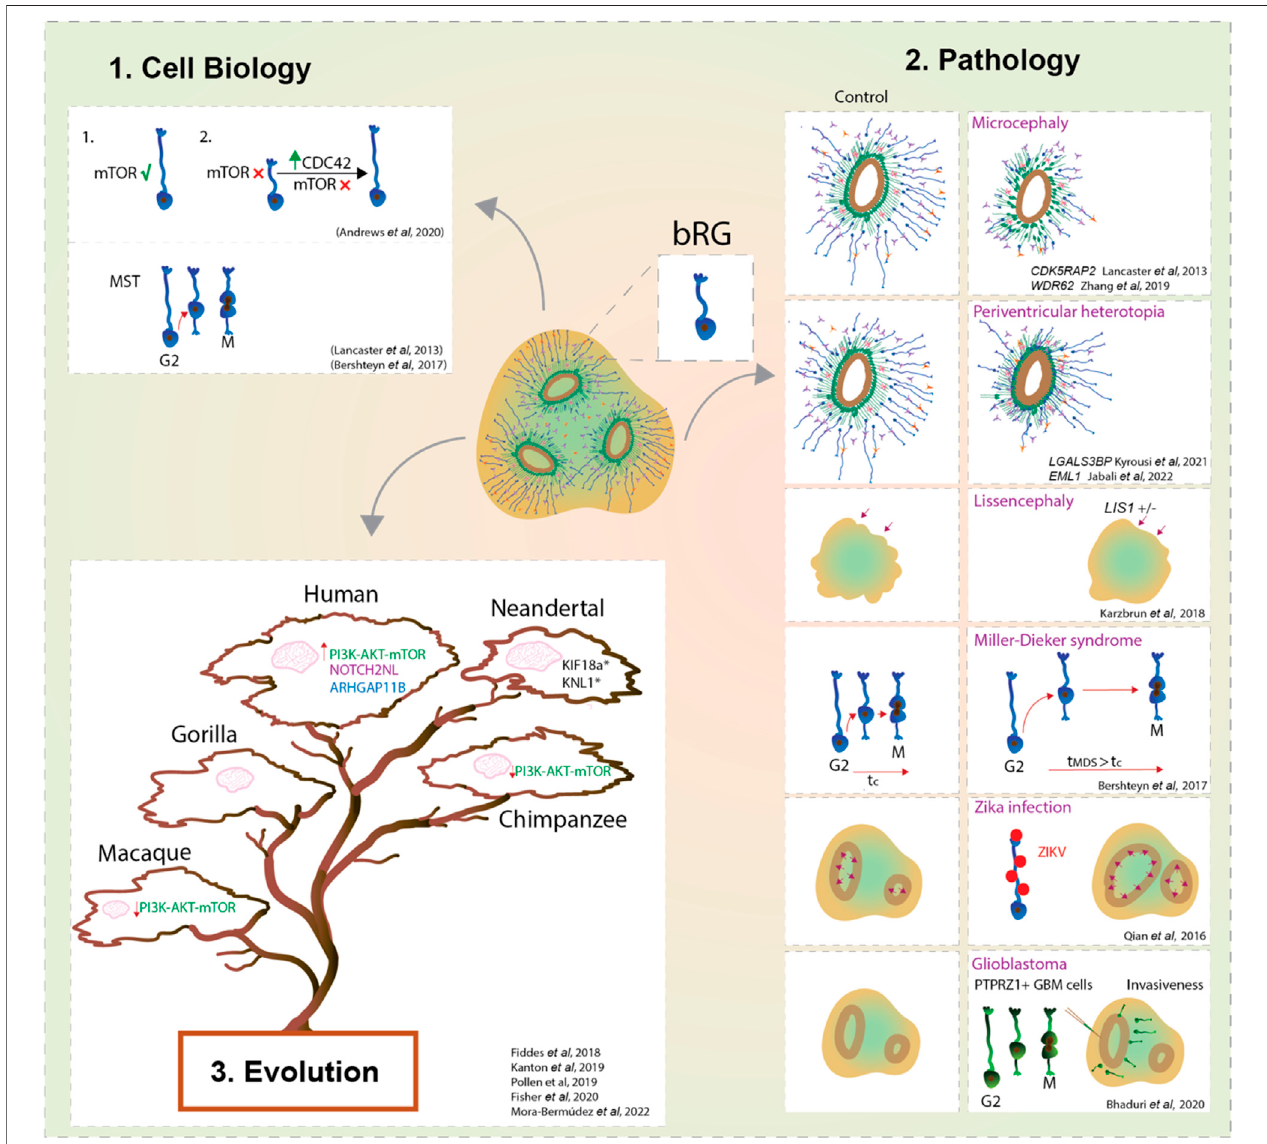
FIGURE 2 | bRG in development, evolution and pathology using forebrain organoids. Forebrain organoids enable us to study the cell biological features and cell behaviours that characterise bRG (1); their role in the onset of malformations of cortical development, brain cancers and viral diseases (2); and their contribution to the neocortex expansion of modern humans compared to ancestral human species and non-human primates (3). Overall, organoids provide a new window into bRG and their link with the expansion of the neocortex.